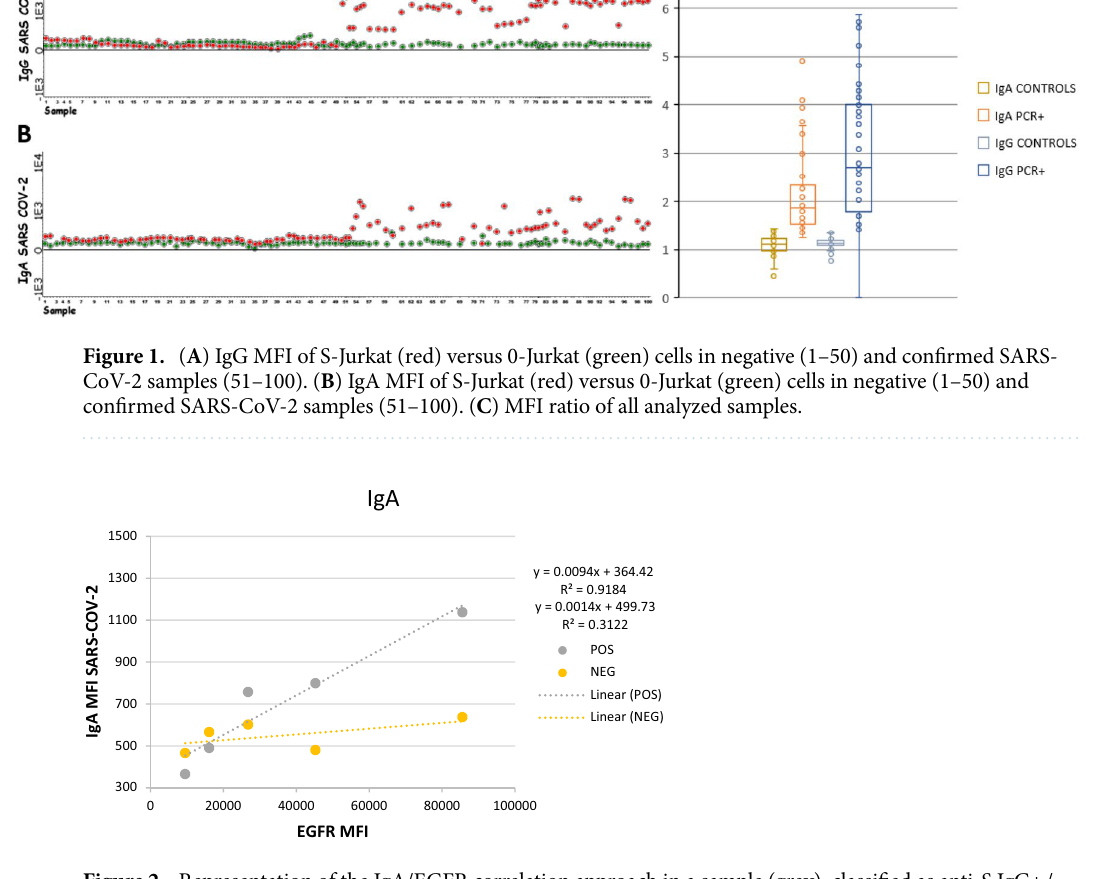
Figure 2. Representation of the IgA/EGFR correlation approach in a sample (grey), classified as anti-S IgG+ / IgA− by the ratio method, and a negative control (yellow). The linear regression graph shows IgA MFI versus EGFR MFI of both samples. The regression coefficient of the sample (grey) versus a negative control (yellow) demonstrate IgA seropositivity (R2 = 0.92 vs. R2 =